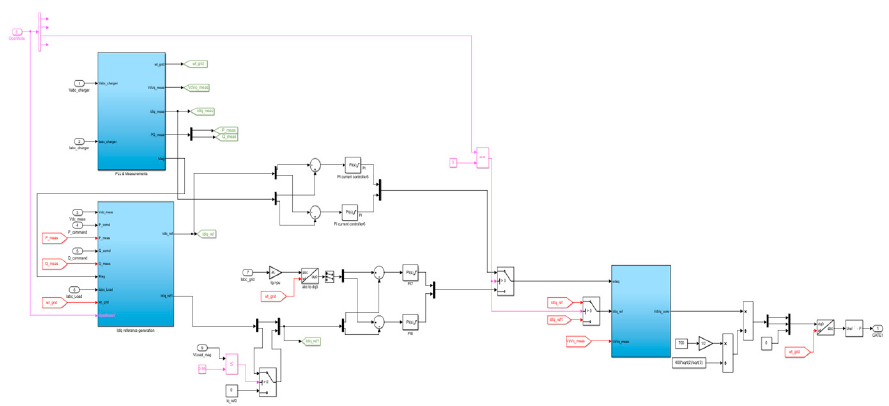
Figure 3. Shunt converter control system.